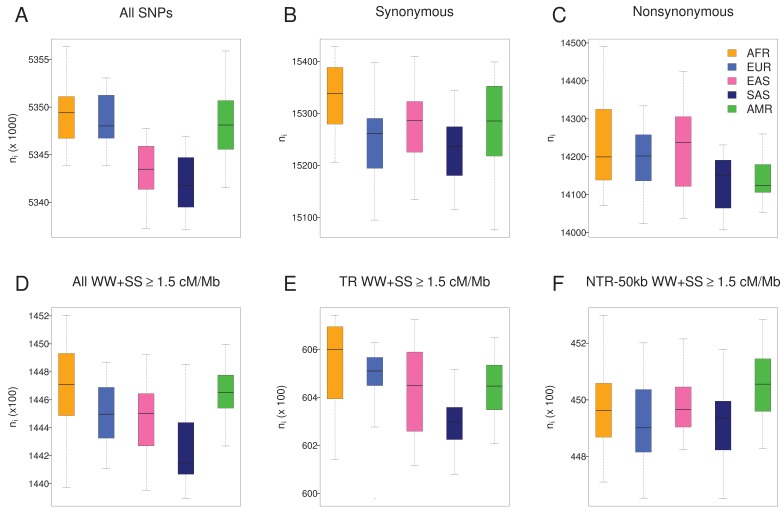
Individual number of derived alleles (ni) for 1000G individuals.Each panel compares the distributions of ni among five geographic regions, with 20 individuals per region. The distribution of ni is broadly similar among geographic regions for all categories of SNPs. (A) ni computed on 17,129,351SNPs. Asians (Eastern, EAS and Southern Asians, SAS) have a significantly lower mean ni than the other three regions (Tukey test, p<0.01). (B) ni computed on synonymous sites. SAS have a lower mean ni than AFR (Africans) (Tukey test, p=0.0004). C) ni computed on non-synonymous sites. SAS have a lower mean ni than AFR (Africans) (Tukey test, p=0.009). D) ni computed on a set of sites assumed to be evolving neutrally (see text and Figure 1). SAS have a significantly lower mean ni count than non-Asians (Tukey test, p=0.0000006). This difference remains in transcribed regions (E) where SAS have a lower mean ni count than AFR (p=0.00005) and EUR (Europeans, p=0.002) but disappears in neutrally evolving non-transcribed regions (F), which suggests that background selection could still be acting in transcribed regions with relatively large recombination in South Asian populations (SAS).